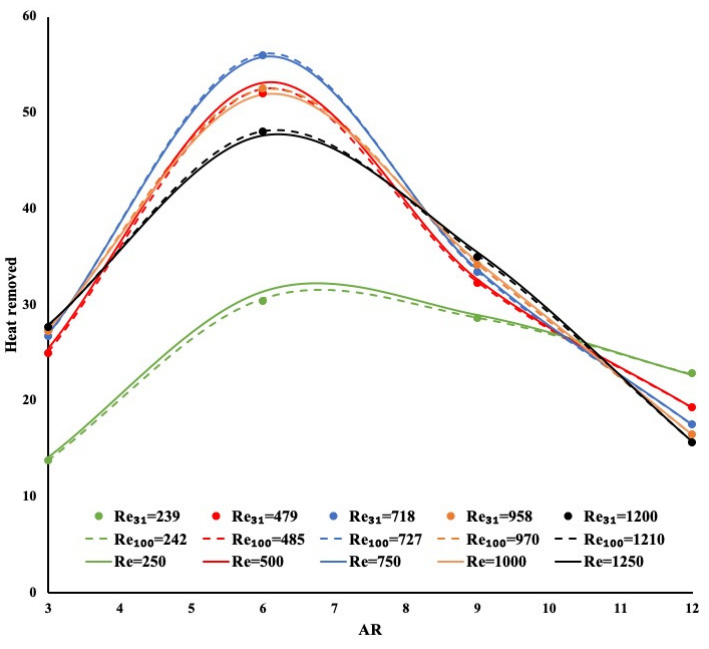
Figure 14. Amount of heat removed for all cases.